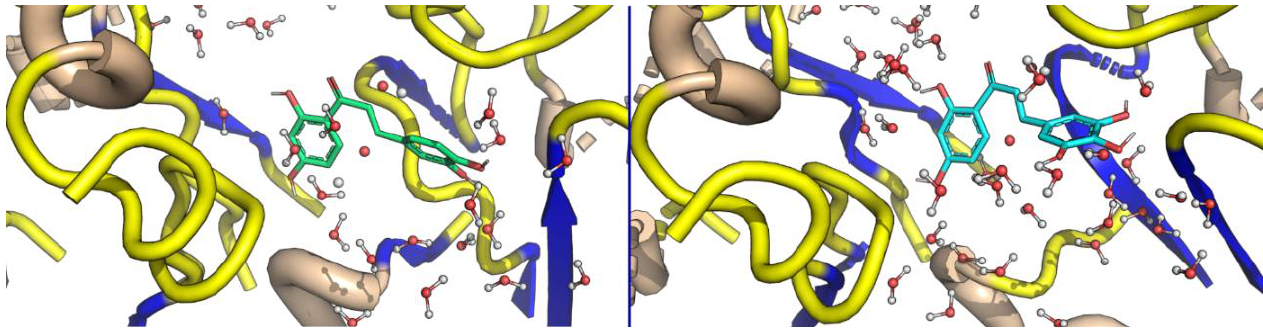
Figure 7. The ligands displace water molecules from the binding pocket.